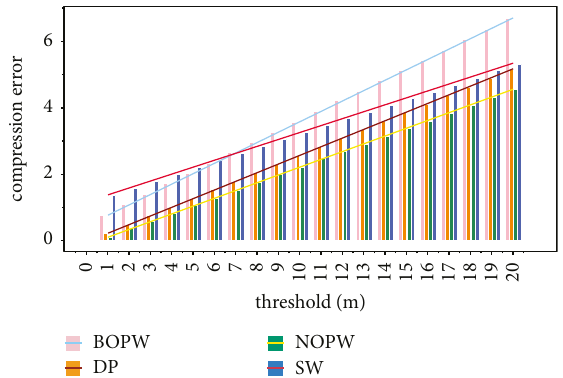
Figure 8: Compression error comparison of different